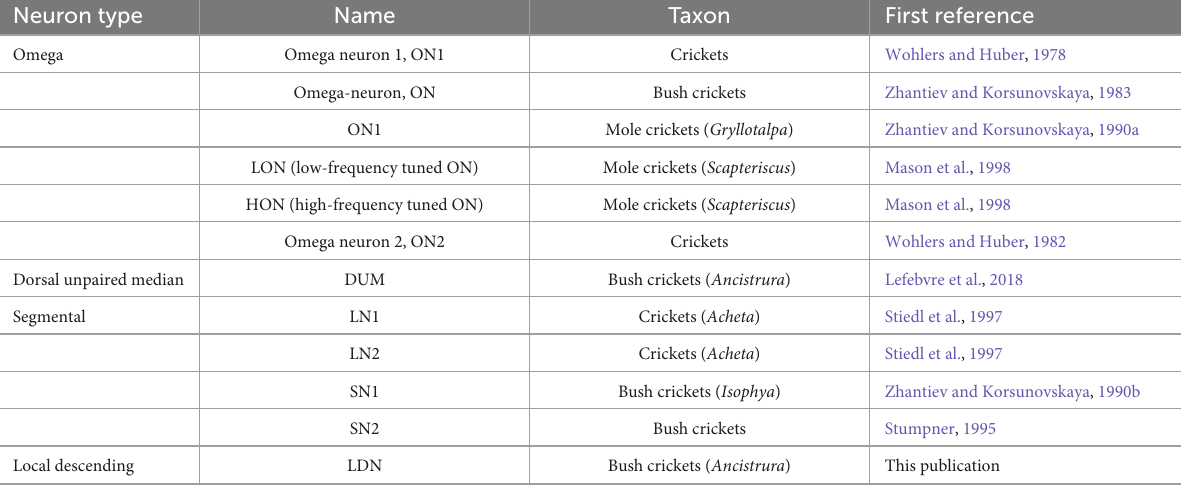
TABLE 1 Types of local neurons and names as published for different taxa. Neuron